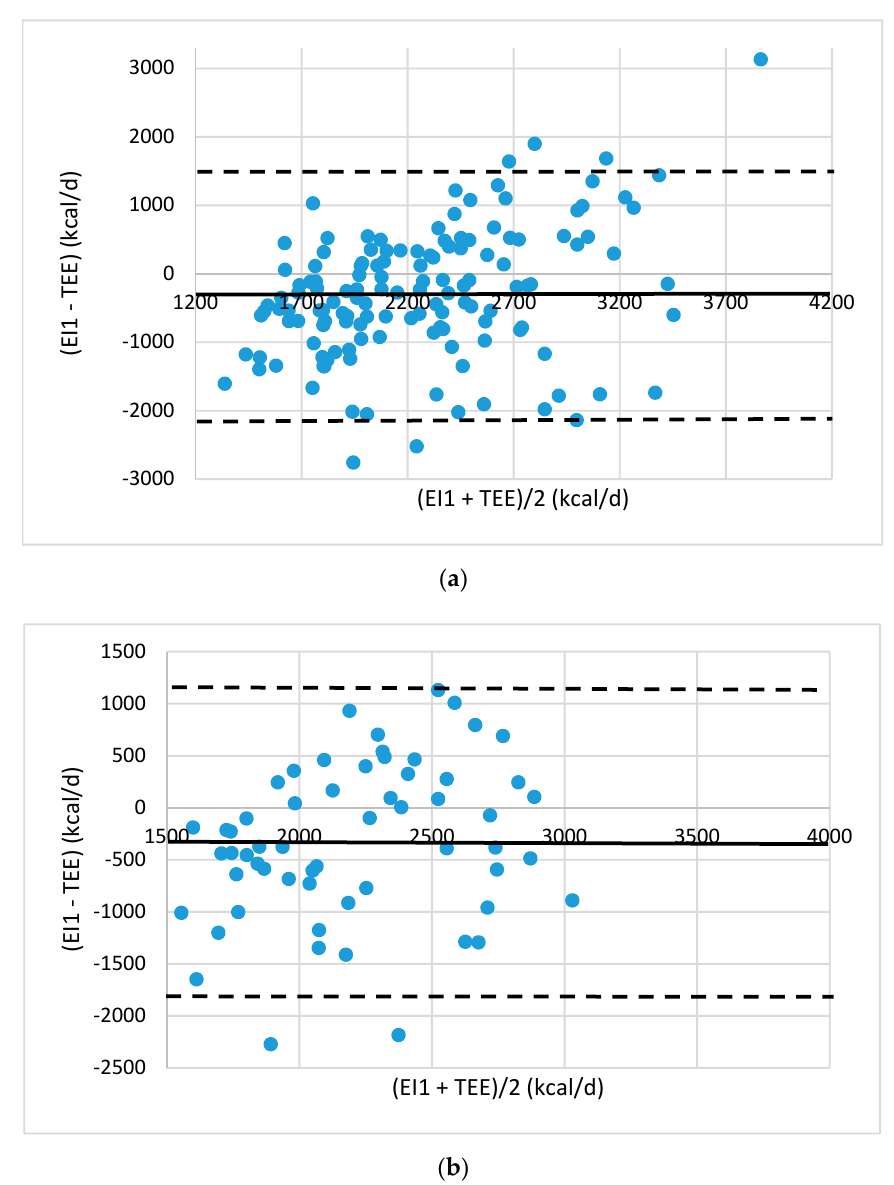
Figure 1. Bland–Altman plots of the agreement level between total energy expenditure (TEE) mea- sured by eMouve, and energy intake (EI1) estimated by NutriQuantic in ( a ) the training and ( b ) the test group. Bias is represented as mean difference (two standard